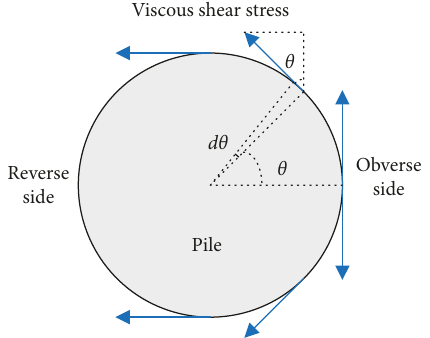
Figure 4: The force analysis of pile